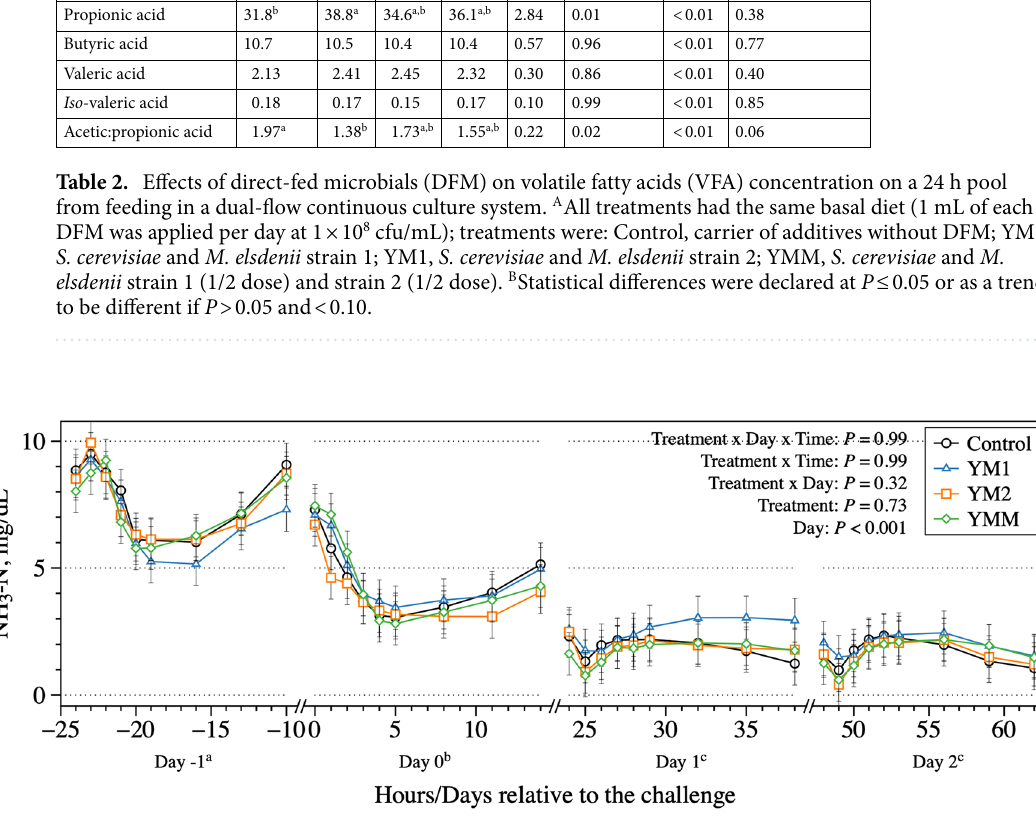
Figure 4. Dynamics of NH 3 –N concentration after the morning feeding on days 8, 9, 10, and 11 of each period to represents the days − 1, 0, 1, and 2 relative to the challenge; day 7 was used as a covariate to the model. All treatments had the same basal diet (1 mL of each DFM was applied per day at 1 × 10 8 cfu/mL); treatments were: Control, carrier of additives without DFM; YM1, S. cerevisiae and M. elsdenii strain 1; YM1, S. cerevisiae and M. elsdenii strain 2; YMM, S. cerevisiae and M. elsdenii strain 1 (1/2 dose) and strain 2 (1/2 dose). Statistical differences were declared at P ≤ 0.05 or as a trend to be different if P > 0.05 and <